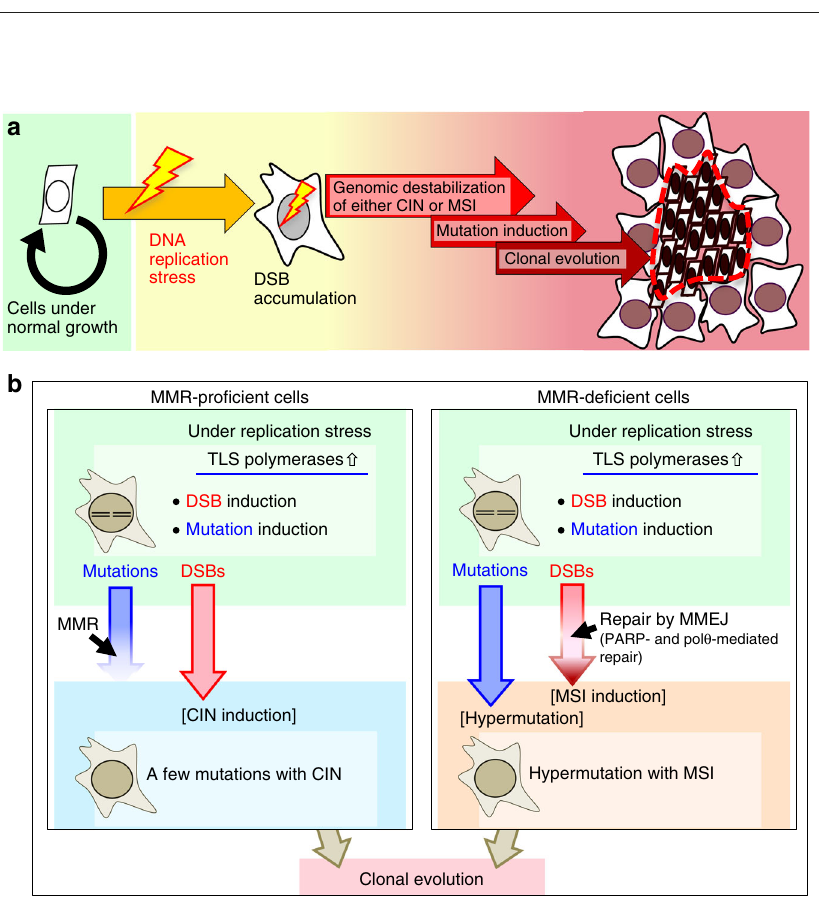
Fig. 6 PARP mediates MSI induction and CIN suppression. a The HCT116 (MMR-de fi cient) and HeLa (MMR-pro fi cient) cancer cell lines were treated as shown in the upper box to induce resistance to CPT. The original and resulting (R2) cells were subsequently treated with CPT, and their survival ef fi ciencies and MSI induction at the indicated loci were assessed. Red arrows indicate the shifted fragment peaks, i.e., MSI. Graphs show mean survival rates ± s.d. ( n = 3 independent experiments with the same cell line). b HCT116 cells treated with HU were cultivated in the presence and the absence of Olaparib and NU7441. Thereafter, γ H2AX foci or γ H2AX/53BP1 foci were monitored by immuno fl uorescence ( n numbers are indicated in graph). Percentages of γ H2AX foci merged with 53BP1 foci (means ± s.e.) are indicated in each image ( n numbers are in images). Bars show means ± s.d. Scale bars, 10 μ m. Two-tailed Welch ’ s t -test was used for statistical analysis. c HCT116 cells, with or without stable down-regulation of Pol θ , were treated with HU (see upper box), and γ H2AX accumulation was monitored by immuno fl uorescence ( n numbers are indicated in graph). Bars are shown as mean ± s.d. Scale bars, 10 μ m. Two- tailed Welch ’ s t -test was used for statistical analysis. d HCT116 cells, with or without stable down-regulation of Pol θ , were treated as shown in the upper- left box to obtain cells resistant to CPT. The resultant and original cells were treated with CPT, and their survival ef fi ciencies and MSI statuses were assessed. Red arrowheads indicate the shifted fragment peaks, i.e., MSI. Graph shows mean cell numbers ± s.d. ( n = 3 independent experiments with three